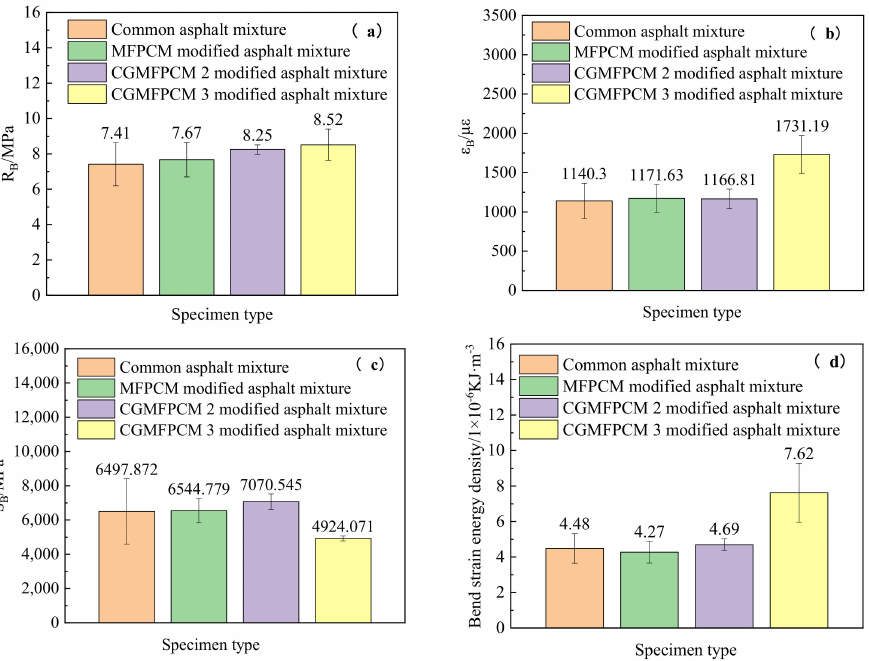
Figure 5. Bending test results for common and modified asphalt mixtures: ( a ) bending strength R B , ( b ) bending failure strain ε B , ( c ) bending stiffness modulus S B and ( d ) bending strain energy density dW dV